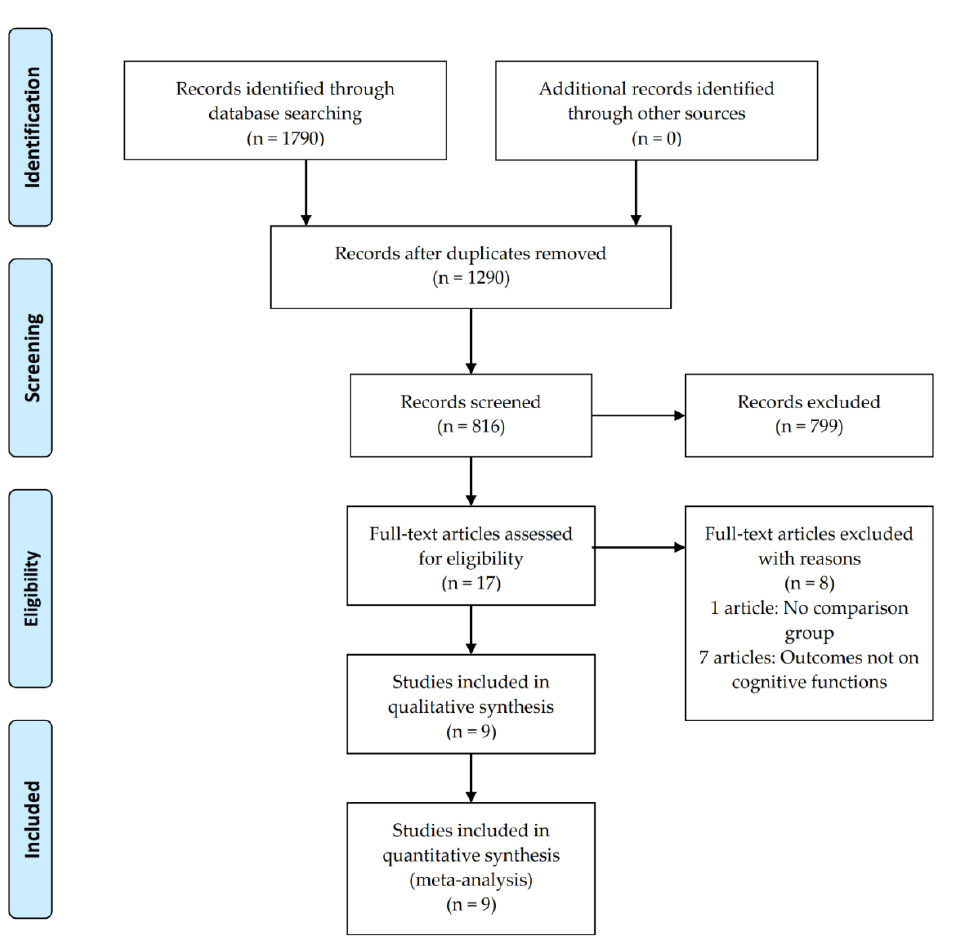
Figure 1. Flowchart of literature identification and selection.